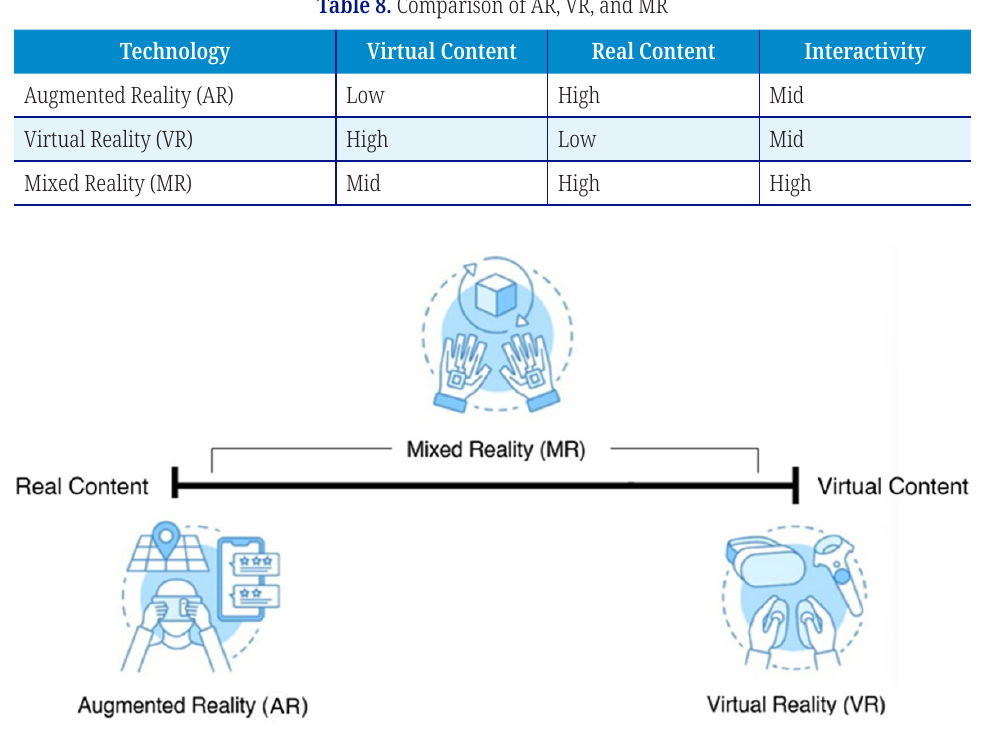
Fig. 13. Comparison of AR, VR, and MR